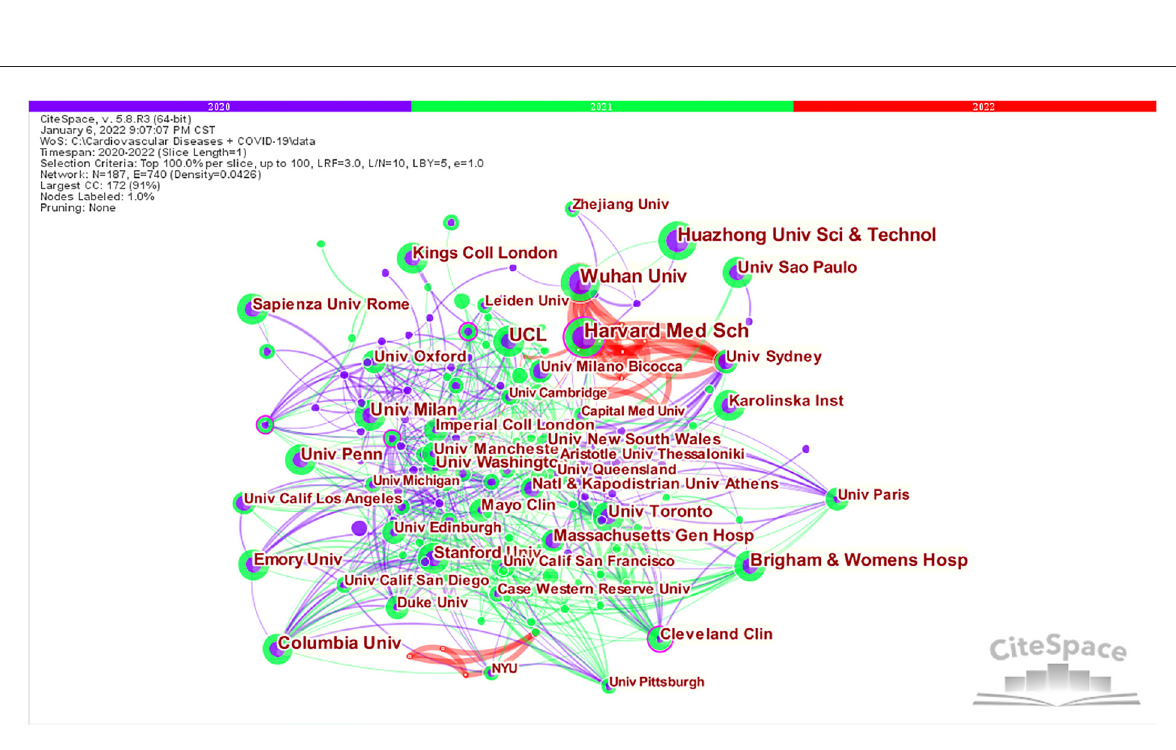
FIGURE3 Visualization map of institutions in the studies of CVDs and COVID-19